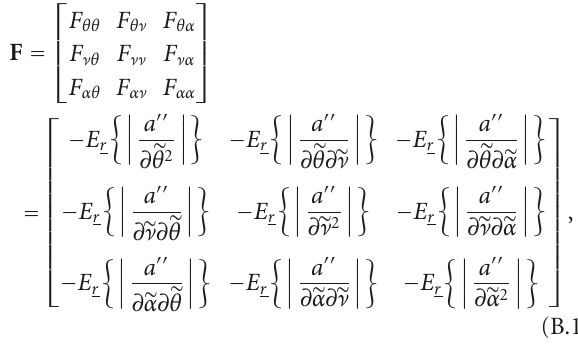
pilot symbols, and (2 x even + 1) is the (odd) number of sub- groups of data symbols; in Figure 12(b), (2 x odd + 1) is the (odd) number of subgroups of pilot symbols, and 2 x odd is the (even) number of subgroups of data symbols. In the se- quel we find the values of x that minimize the VCRB s of ν and α , for fixed values of L , N , and M . In the case of joint phase/Doppler-shift/Doppler-rate es- timation, the fisher information matrix (FIM) of the generic bursts of Figure 12 can be written